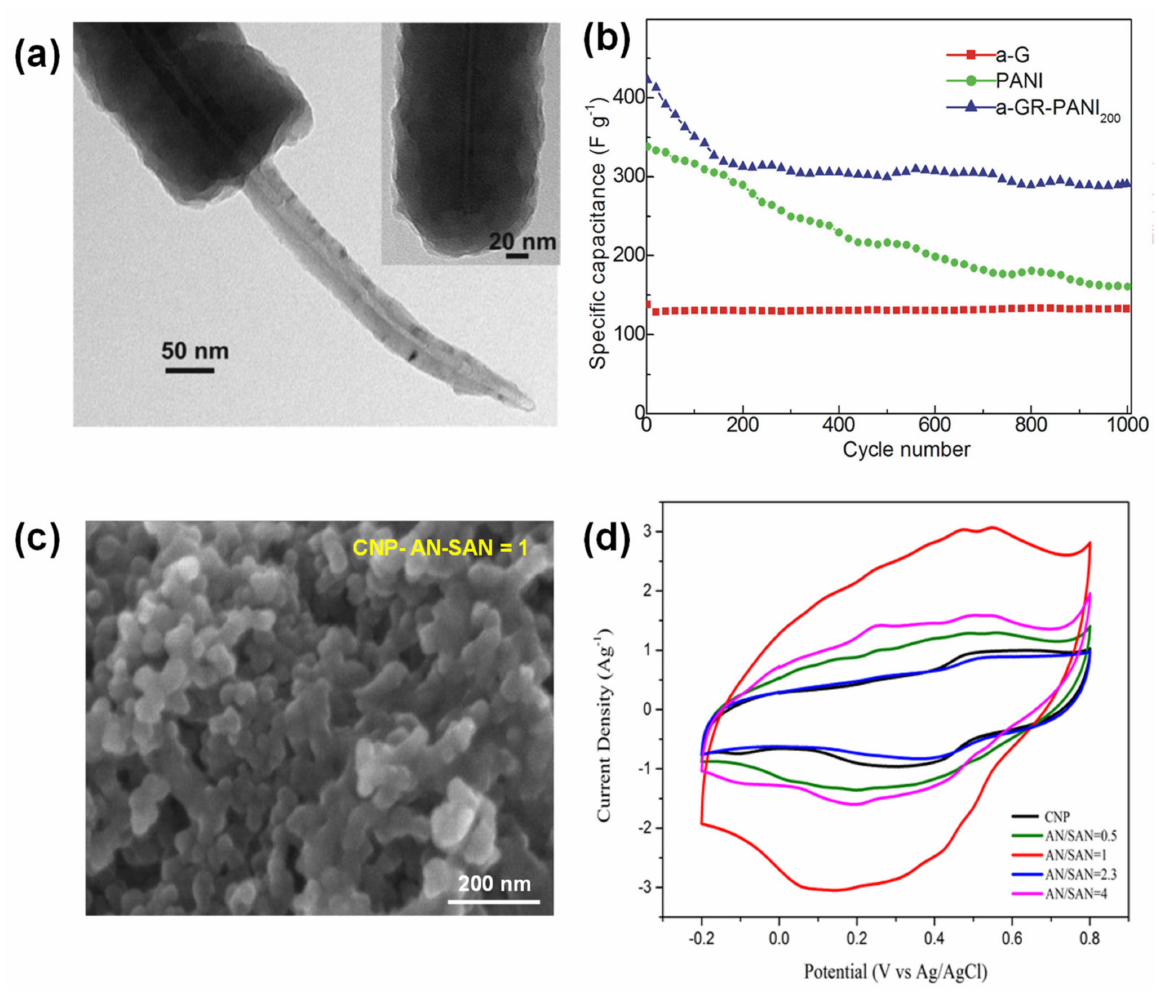
Figure 7. ( a ) TEM image of PANI-CNT composite, ( b ) cycling stability of PANI-CNT, ( c , d ) SEM micrograph of the optimized composite and CV profile comparison of carbon black (CNP) and CNP electrochemically modified with AN/SAN at ratio from 1 to 4. Reproduced with permission from Refs.